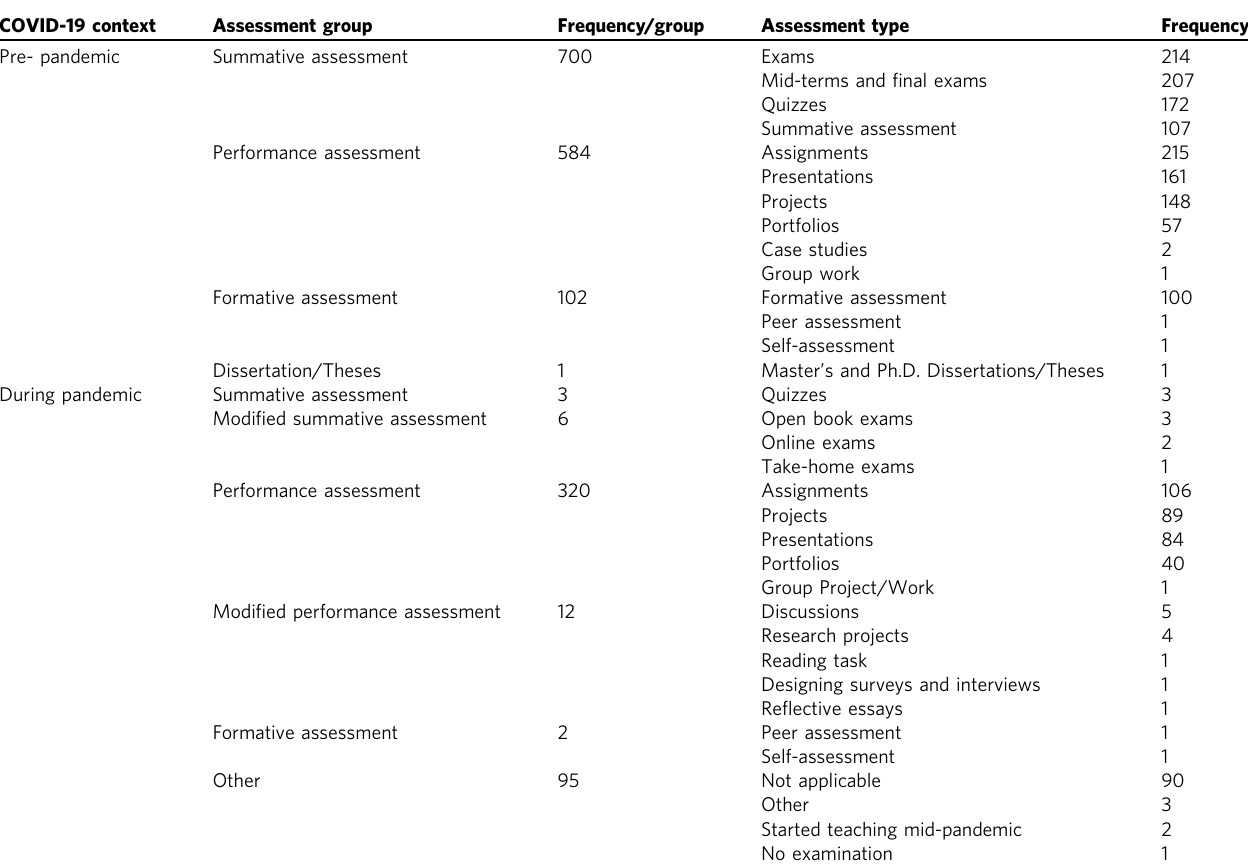
Table 5 Frequencies of assessment practices pre- and during the COVID-19 pandemic categorised by assessment